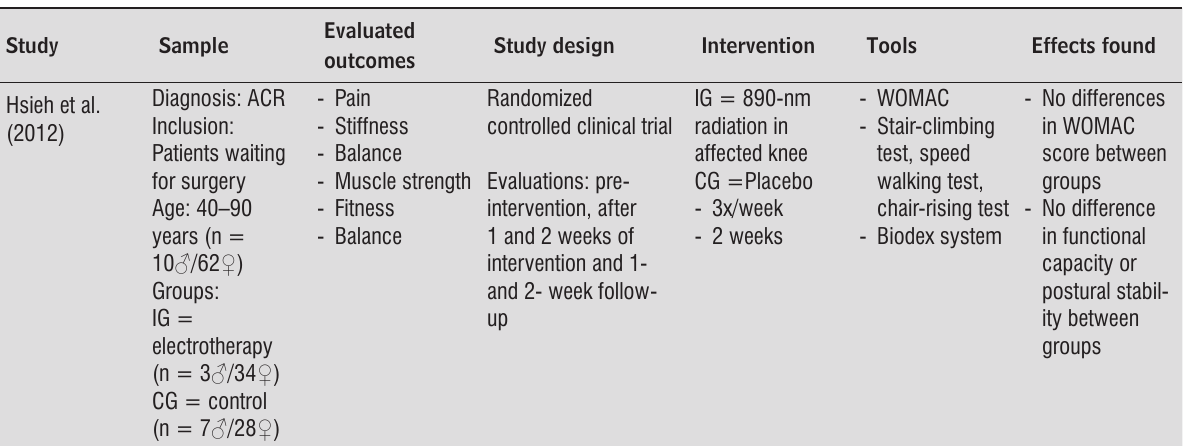
Table 2 - General data of the selected